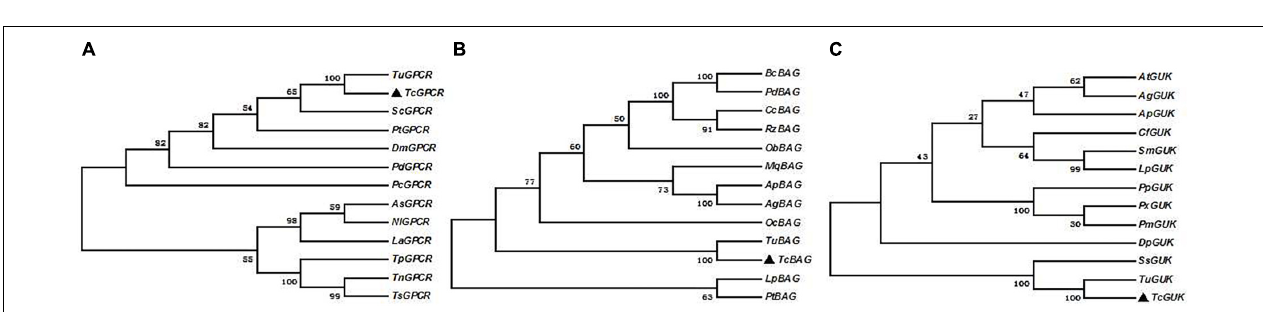
FIGURE 6 | Schematic drawing of TcGPCR, TcBAG, TcGUK . C, C-terminal region; N, N-terminal region; TM, transmembrane helices; BAG, BAG domain; GK, guanylate kinase-like domain.